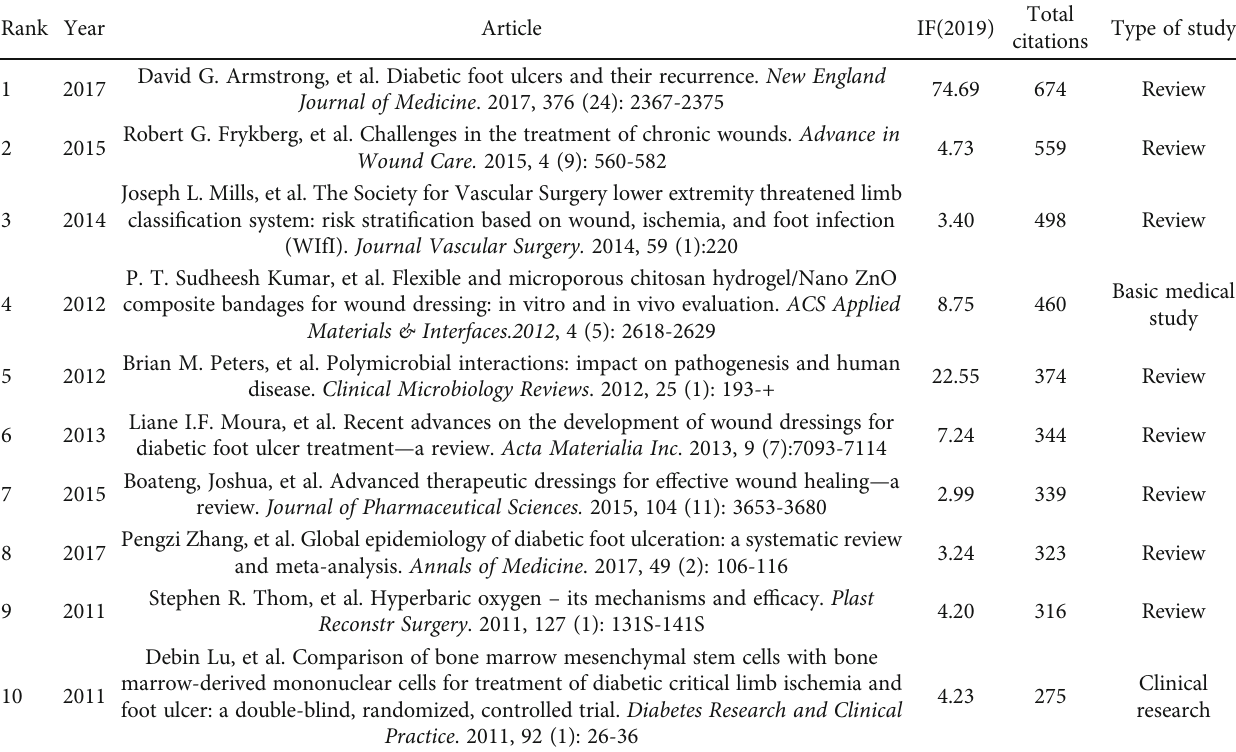
Table 2: Top 10 most cited